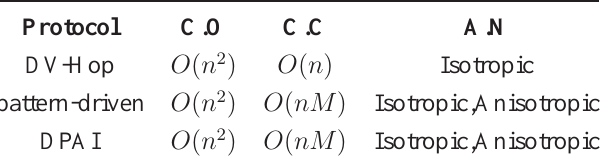
Table 1. Protocol